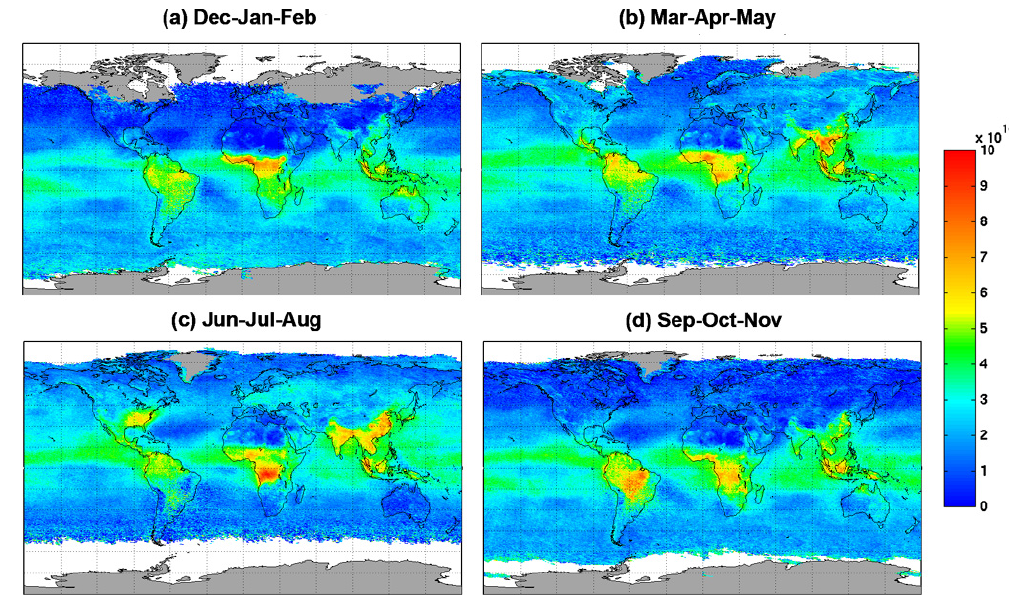
Fig. 10. Global maps of seasonally averaged vertical columns of glyoxal retrieved from GOME-2 measurements between 2007 and